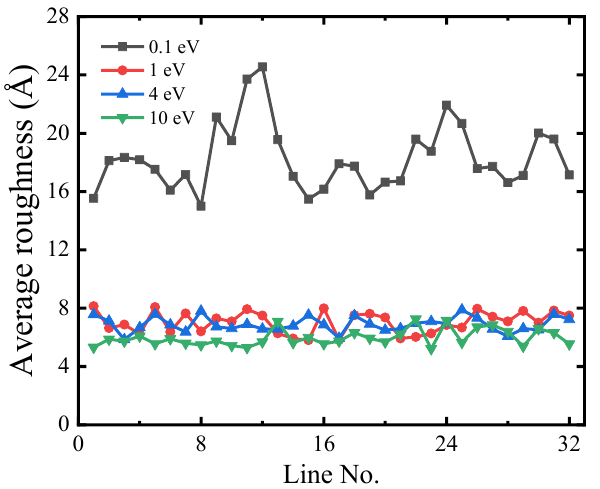
Figure 3. Effect of different incident energies on the line RMS roughness of the TiN thin film.